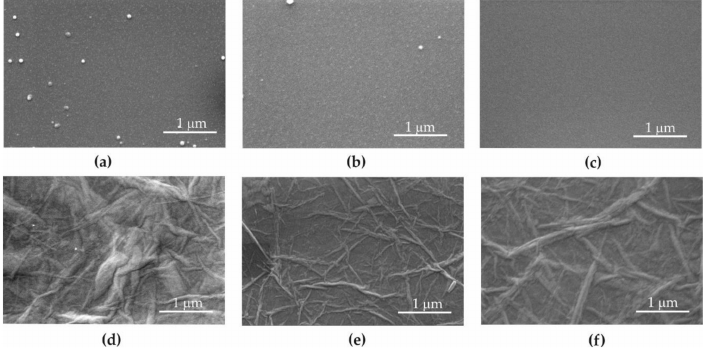
Figure 3. SEM images of the surface. ( a ) Unmodified Petri dish; ( b ) after plasma cleansing; ( c ) plasma cleansing and UV sterilization; ( d ) plasma cleansing and GO deposition; ( e ) plasma cleansing, GO deposition, and vacuum dryer; ( f ) plasma cleansing GO deposition, vacuum dryer, and UV